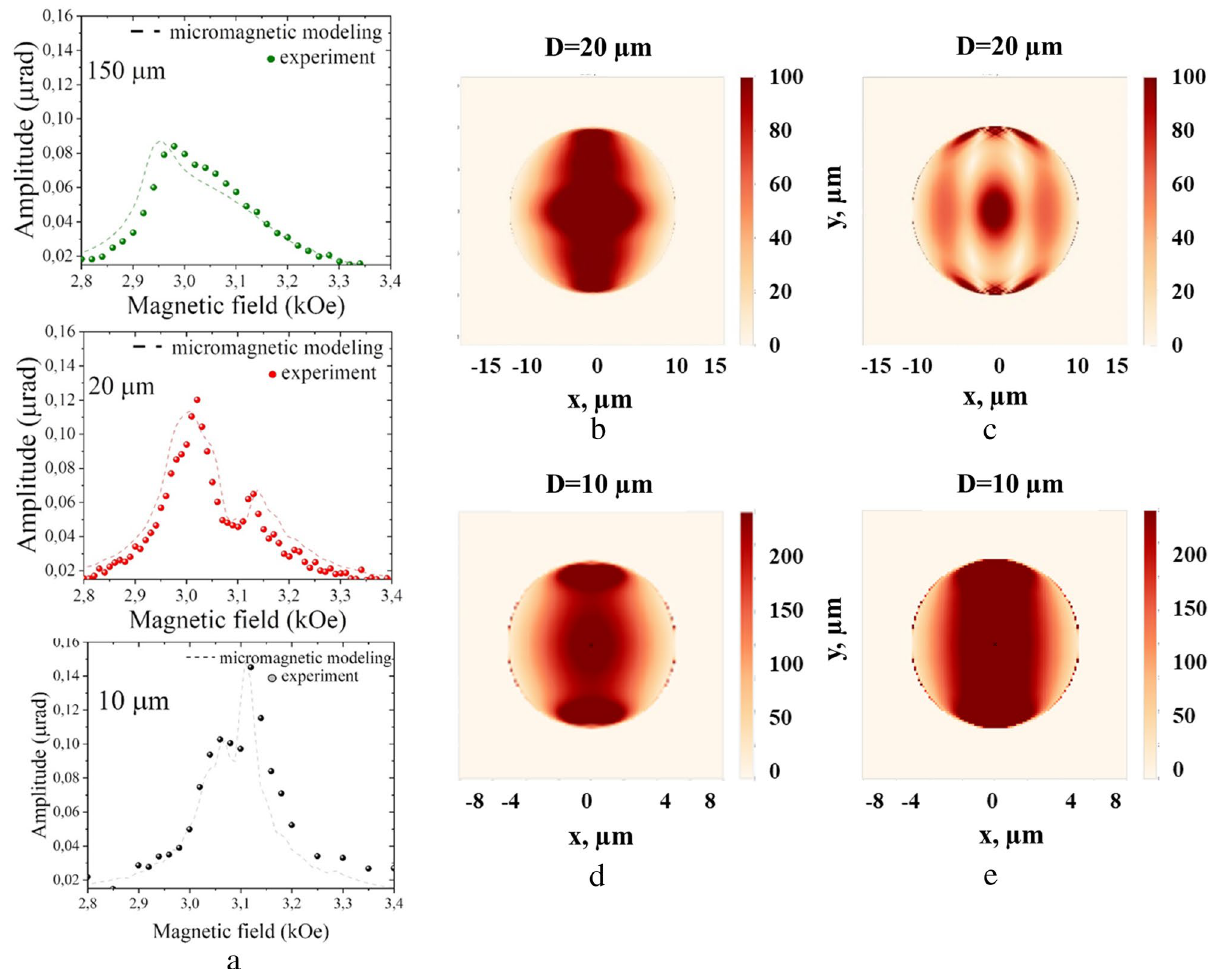
Figure 2. ( a ) Experimental data of the amplitude of the magnetization precession dependence on the magnetic field for disks of 150, 20 and 10 µm diameter (circles), as well as micromagnet modeling results of the magnetization precession amplitude (dashed lines), the energy density is 5.2 µJ/ cm 2 . ( b - e ) Spatial distribution of the spin wave amplitude for the 20 μm disk at H = 3.01 kOe ( b ) (the lower field resonance peak), and at H = 3.14 kOe ( c ) (the higher field resonance peak), for the 10 µm disk at H = 3.07 kOe ( d ) (the lower field resonance peak), and at H = 3.12 kOe ( e ) (the higher field resonance (Fig. 2a). For smaller disks the field H r 0 starts to increase. For example, for the 20 µm disk H r 0 = 3.01 kOe (Fig. 2a, red circles). The peak shift by 30 Oe is due to the smaller average demagnetizing field H d of the microdisk with respect to the film. Equation (3) gives the correct value of H r 0 if the average demagnetizing field of the 20 µm disk is H d = 1.24 kOe. Notably, for the 20 µm disk a second peak appears at H r 2 = 3.14 kOe. Its origin can be understood from the calculated spatial distribution of θ 0 (Fig. 2b-e). Here the best correspondence between experimental and modeling data is achieved for the fully unpinned boundary conditions. Periodic pumping at 10 GHz repetition rate singles out different magnetostatic modes of the disk formed by standing spin waves. As the modes are formed by BVMSWs, the interference takes place along the external magnetic field, i.e. one or several amplitude maxima appear in x-axis direction. Thus, the mode excited at H r 0 = 3.01 kOe is the standing spin wave of the first order ( n x = 1), while the mode at H r 2 = 3.13 kOe is of the third order ( n x = 3). The amplitude of the spin precession in the 10 µm disk also has two peaks at 3.07 kOe and 3.12 kOe. At a magnetic field of 3.12 kOe the first-order ( n x = 1) mode of the BMSW is excited (Fig. 2e), while origin of the lower field peak at 3.07 kOe should be different since the amplitude distribution doesn’t correspond to any BMSW modes and it demonstrates interference in y-axis direction (Fig. 2d).Moreover, it follows from the amplitude distribution, that the modes is also of the first order, therefore its wavelength obeys the same condition: (cid:31) = 2D . As resonance magnetic fields for the two modes are different it means that the modes have different dispersion and, therefore, different character. It hints again on the excitation of MSSW as it was observed for the point (IV) in the 300-µm disk. However, this time their resonance is more pronounced. Amplitude distribution in Fig. 2d confirms interference along y-axis and MSSW character in this case. Therefore, the lower field resonance peak is due to the first order ( n y = 1) MSSW mode. Thus, a spatial confinement provides more efficient excitation of